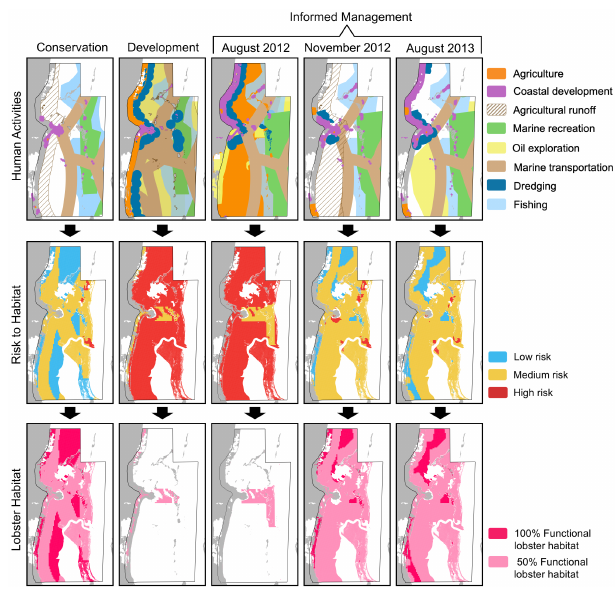
Fig. 4 . Planned human activities; risk to mangrove, seagrass, and coral habitats; and resulting functional lobster habitat in the Central Region for the conservation, development, and three iterations of the informed management (August 2012, November 2012, and August 2013) scenarios in Belize.